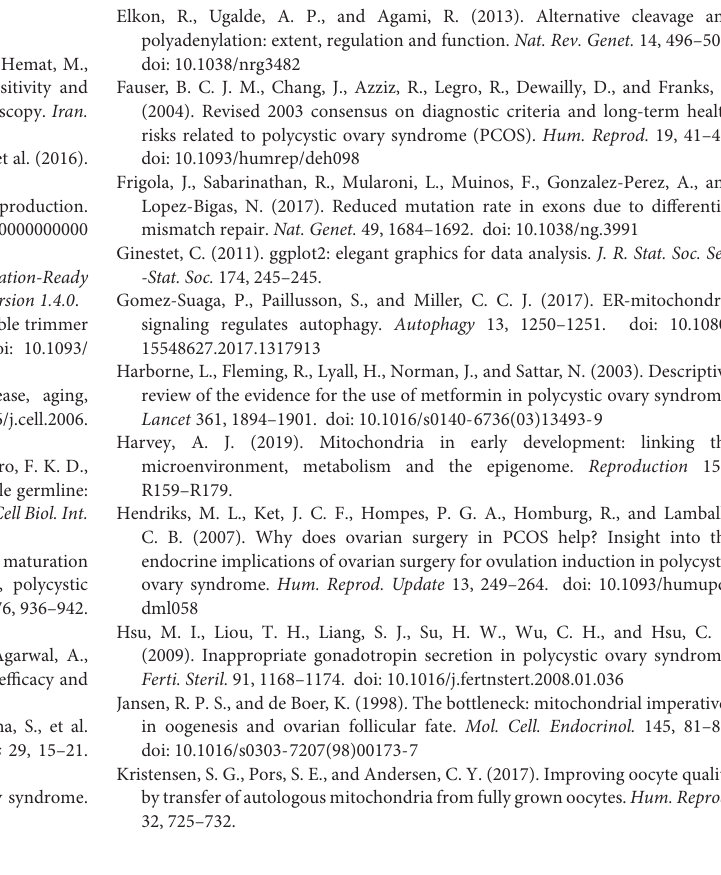
FIGURE S1 | GO analysis of hub genes in different modules. (A) GO terms of hub genes in blue module. (B) GO terms of hub genes in yellow modules. (C) GO terms of hub genes in magenta module. TABLE S1 | Genes list for three significantly gene modules. TABLE S2 | Differentially expressed genes of GV, MI and MII stages between PCOS and healthy group. TABLE S3 | Overlap genes of venn